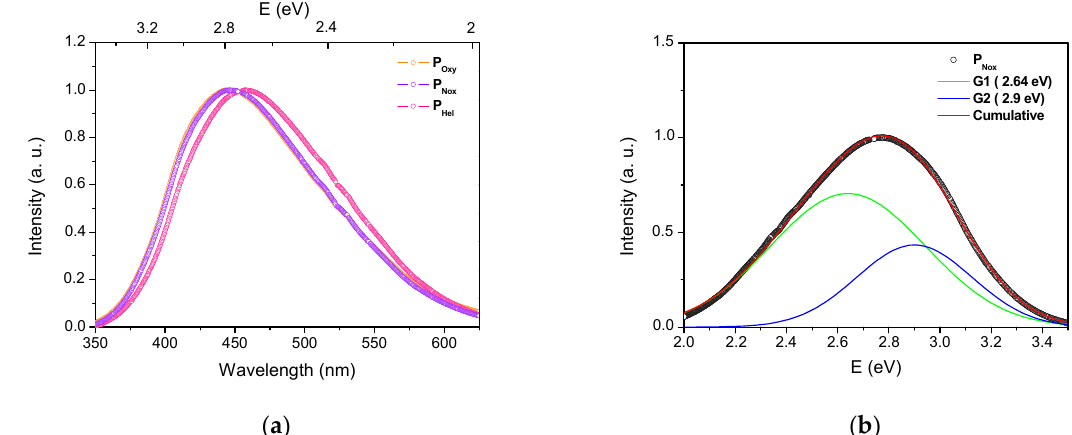
Figure 3. ( a ) Normalized PL spectra of the three Ce-doped preforms under excitation at 320 nm. ( b ) PL spectrum Gaussian shape decomposition for the P Nox sample. Table 1. Normalized areas of Gaussian sub-bands (in %) composing the PL spectra of the three Ce-doped preforms under excitation at 320